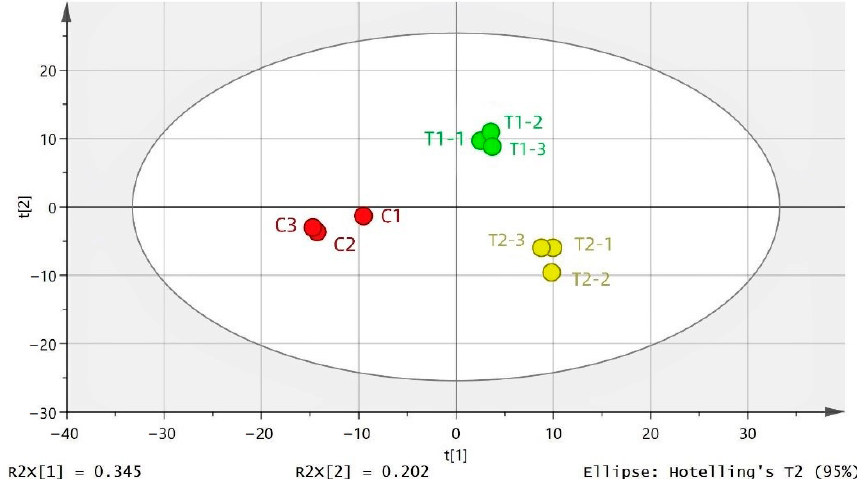
Figure 1. PCA results of FAAs in MPR samples with different processing. C: Control group; T1: test group 1 (using the improved technology of Sichuan spicy flavor formula); T2: test group 2 (using the improved technology of halogen flavor formula).